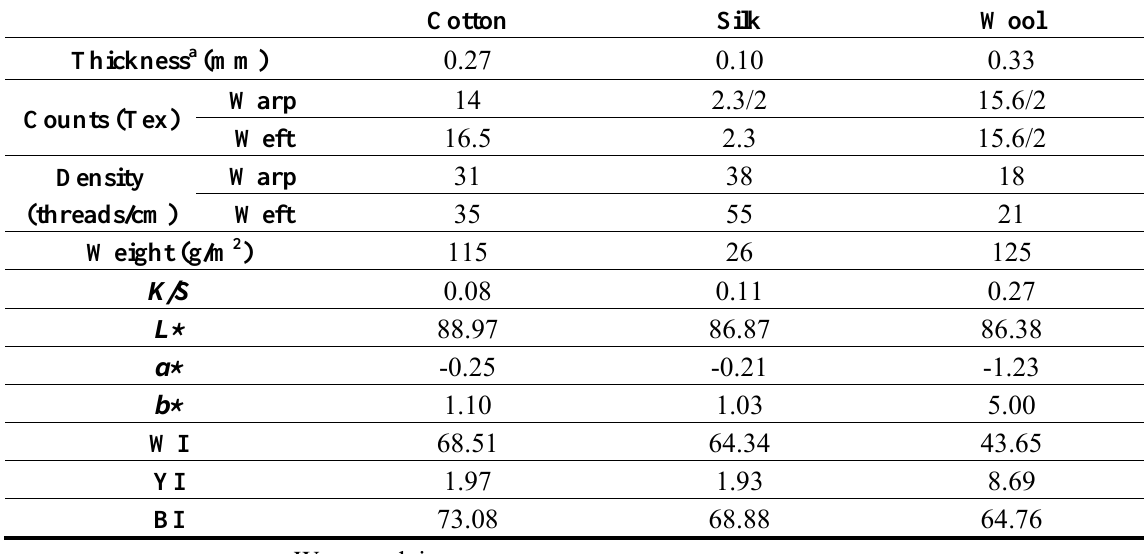
Table 3. Characteristics of fabric